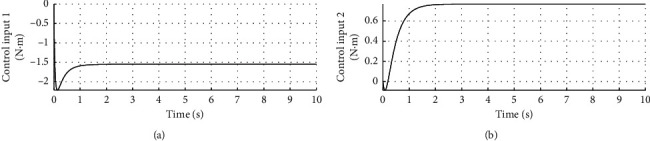
Control input curve.